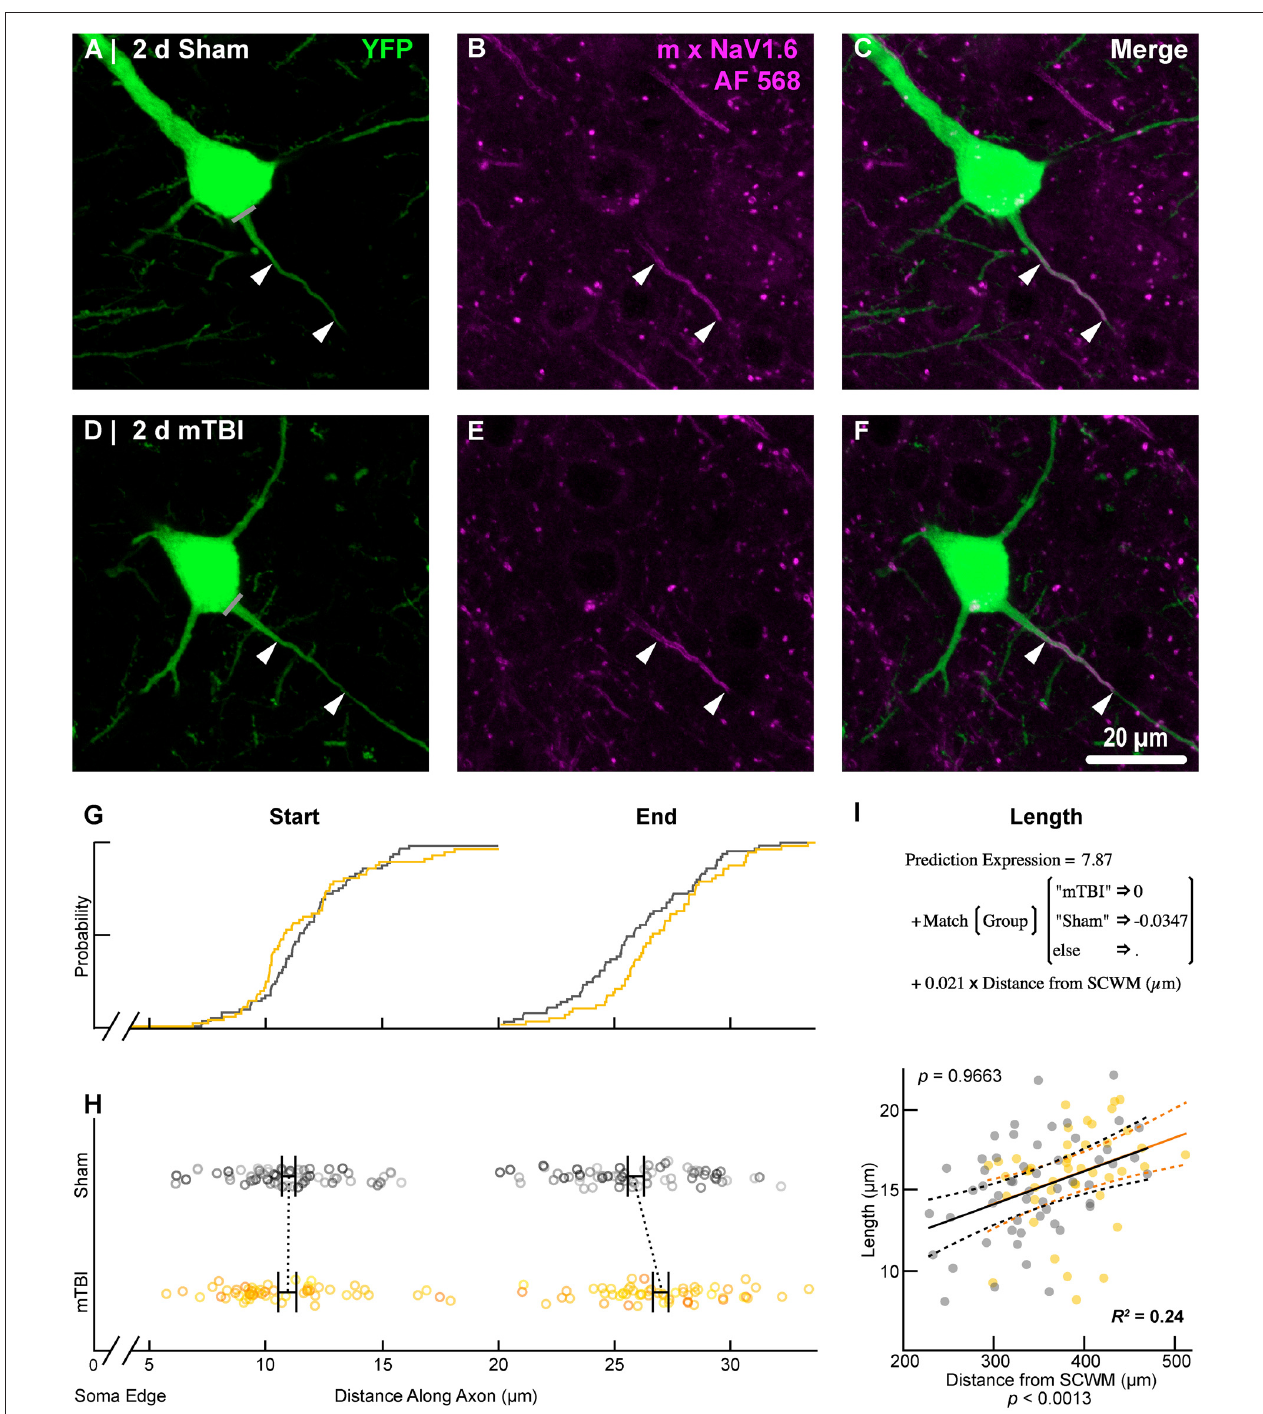
FIGURE 8 | NaV1.6 geometry does not change after mTBI. Representative images of sham (A–C) and mTBI (D–F) of YFP ( A,D ; green) and NaV1.6 ( B,E ; magenta). (C,F) Composite image showing YFP+ axon colocalization with NaV1.6, demarcating the distal AIS. (G–I) Quantitative analysis of NaV1.6 profiles of sham (gray) and mTBI (gold). (G) Cumulative frequency distribution plots showing overlap in start position but a distal shift in mTBI end position. (H) Multilevel analysis of start and end positions with animals as a random variable depicted by different shades. Data summarized with means and SEM error bars. Note that there was no change in NaV1.6 start or end position. (I) Multilevel analysis of NaV1.6 length with animals as a random variable and distance from SCWM as a covariate. Plot of NaV1.6 length as a function of distance from SCWM (solid lines) with 95% CI (dashed lines) for sham and mTBI. Distance from SCWM is a significant covariate of NaV1.6 length. This accounted for the overlap in sham and mTBI plots compared to the shift seen in the uncorrected distribution of the end position (G) .